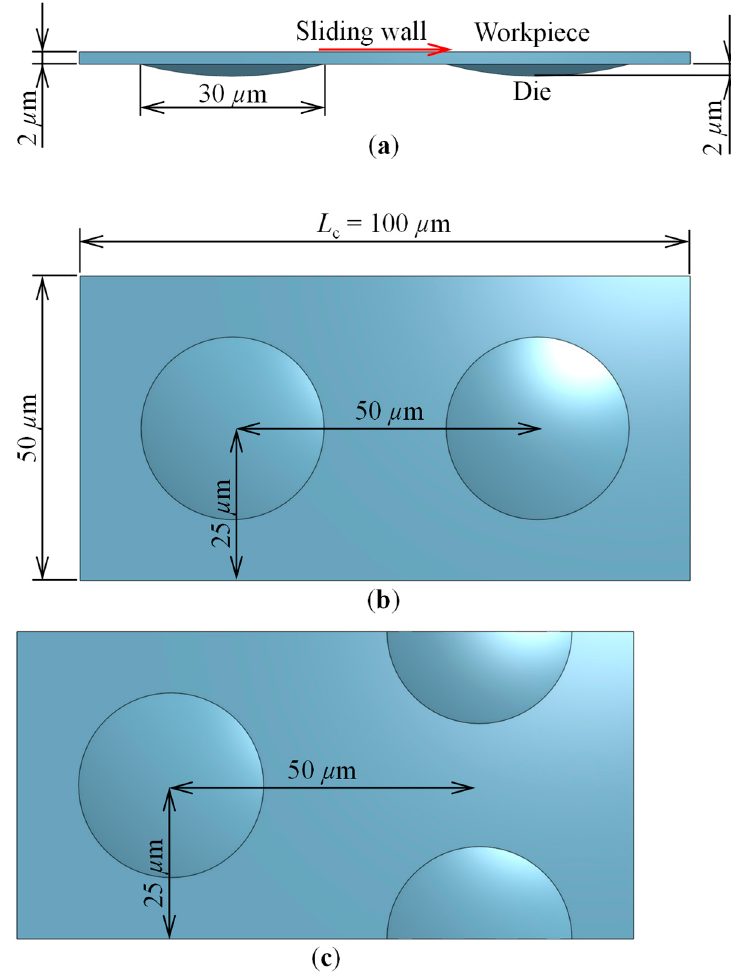
Figure 5. Geometrical model of the simplified contacting couple and the computational fluid domain